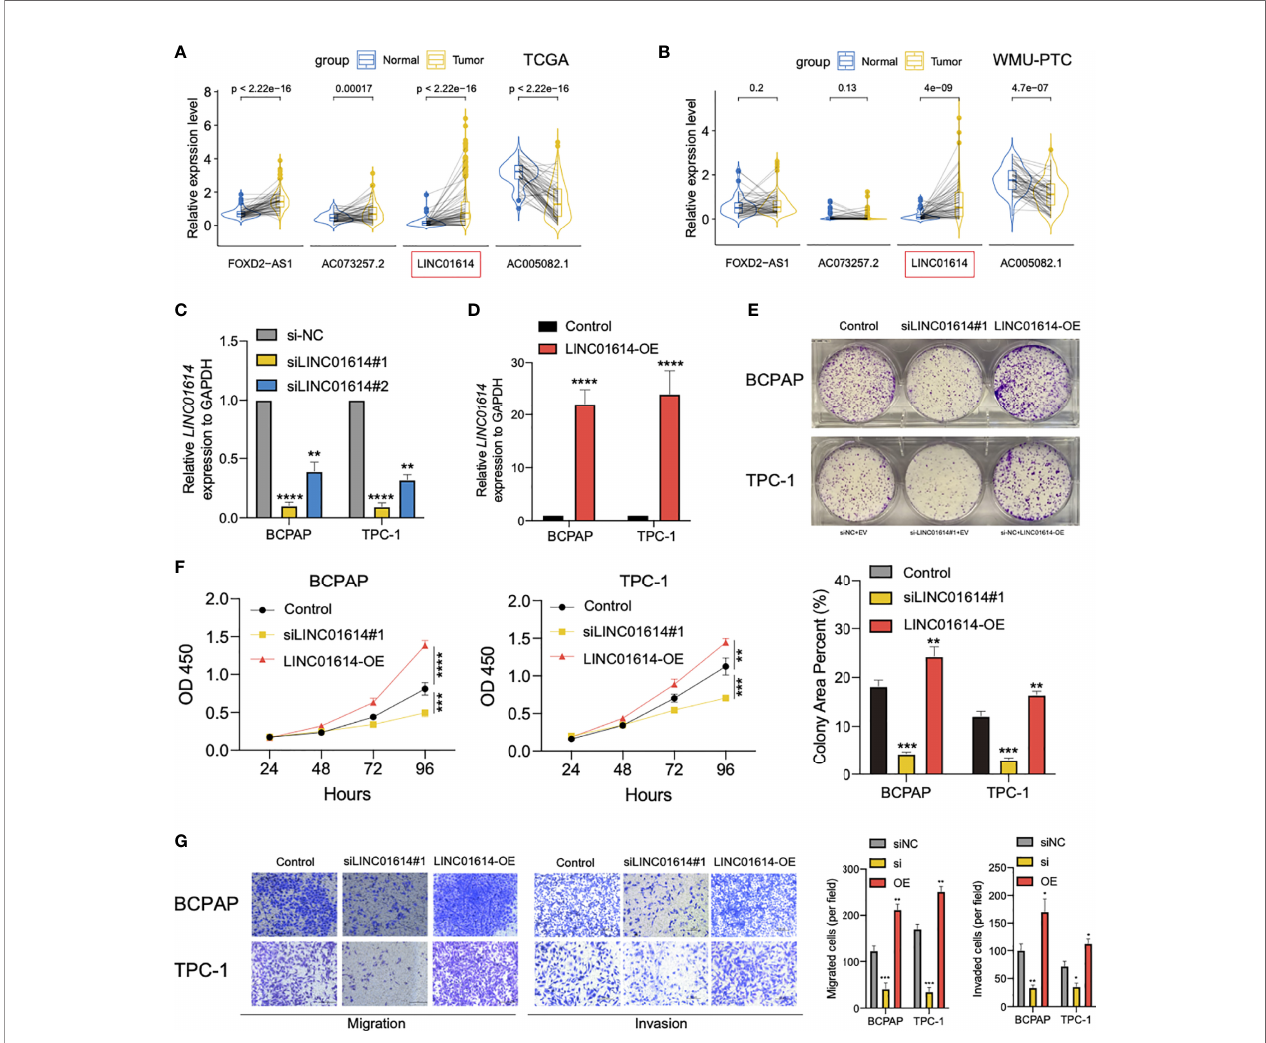
FIGURE 9 | LINC01614 behaved as an oncogene in PTC cells. The pairwise expression of individual lncRNAs in tumor and normal tissue for (A) TCGA cohort and (B) WMU-PTC cohort. (C) The silencing ef fi ciency of siRNA targeting LINC01614 was analyzed by qPCR after transfected for 48 hours in either TPC-1 or BCPAP cells. (D) qRT-PCR showing the relative expression of LINC01614 in mRNA level in PTC cells transduced with empty vector or LINC01614 -overexpressing plasmid. (E, F) Colony formation and CCK-8 assays were performed to test the survival of PTC cells after silencing or overexpressing of LINC01614 . (G) Transwell assays were carried out to test the migration and invasive activity of LINC01614 altered PTC cells. The results above were summarized as bar graph. All data are the means ± SD of three experiments. * p < 0.05, ** p < 0.01, *** p < 0.001, **** p <